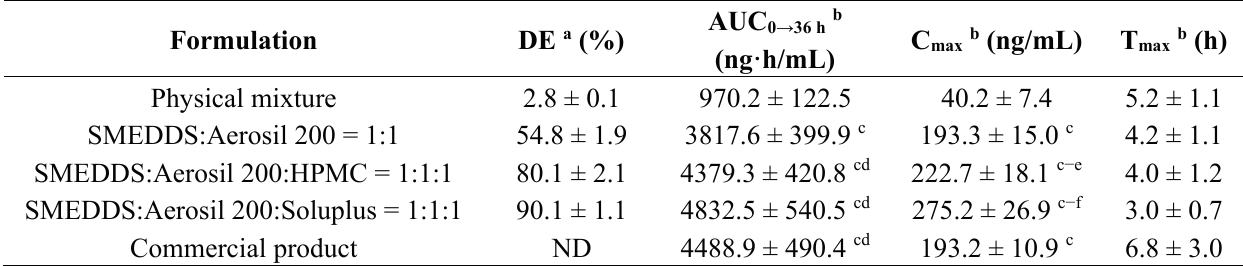
Table 2. Dissolution efficiency and pharmacokinetic parameters for physical mixture, dutasteride-loaded solid-supersaturatable SMEDDS, and commercial product.